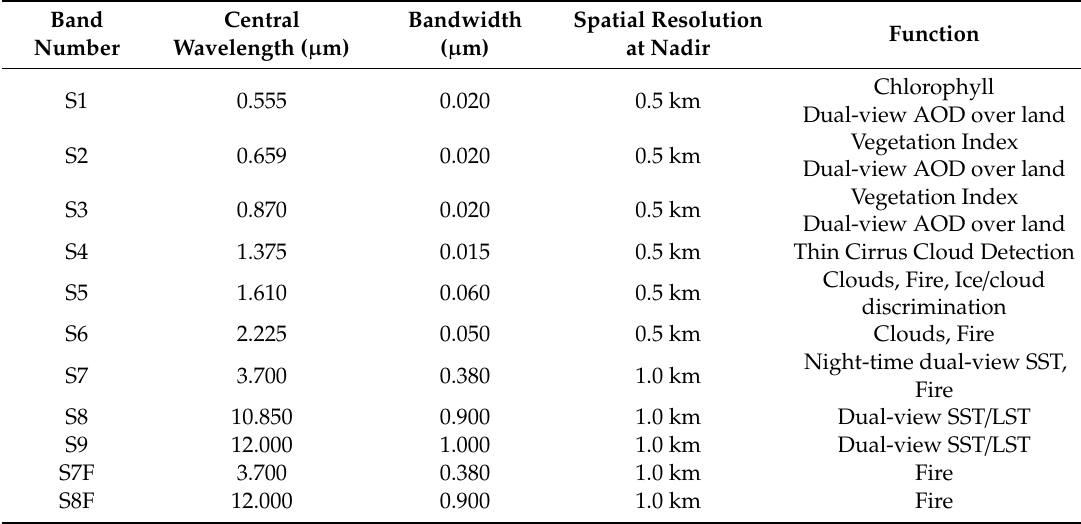
Table 1. SLSTR spectral